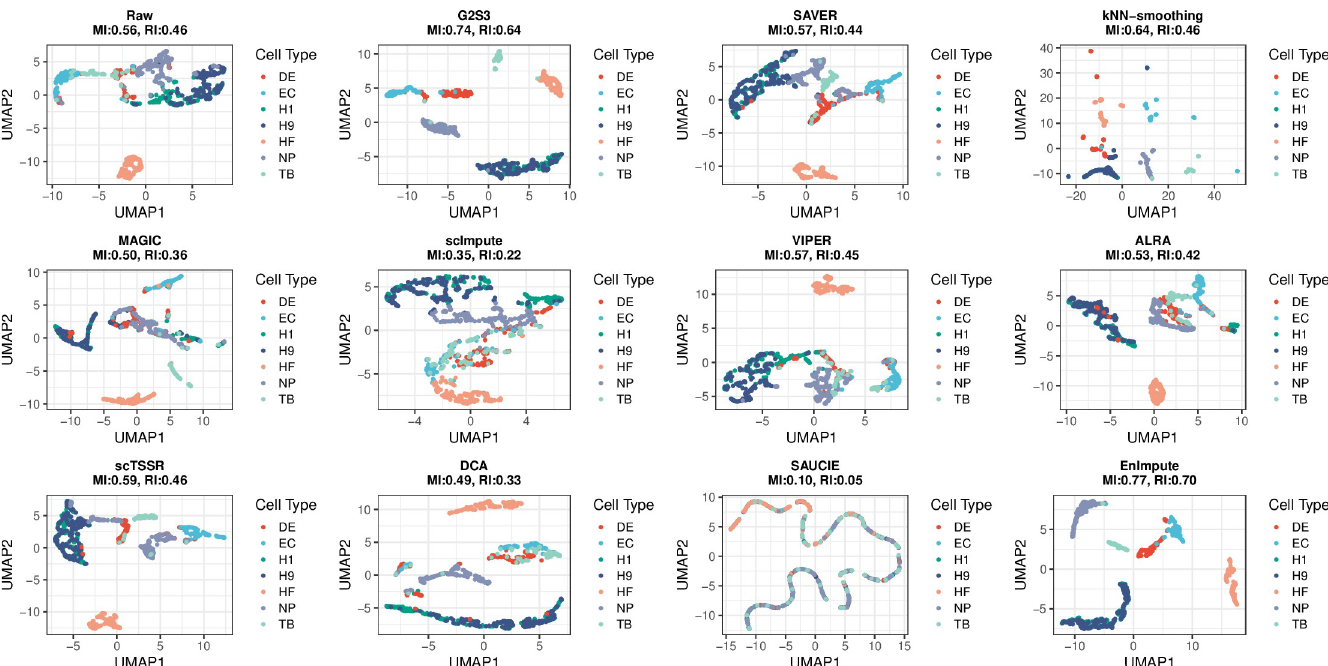
Fig 3. Plots showing 2D-Visualization of the Chu dataset. UMAP plots of the raw unimputed and imputed data by all methods. Cells are colored by true cell subtype labels. The normalized mutual information (MI) and adjusted rand index (RI) are calculated to measure the consistency between cell clustering results and true cell subtype